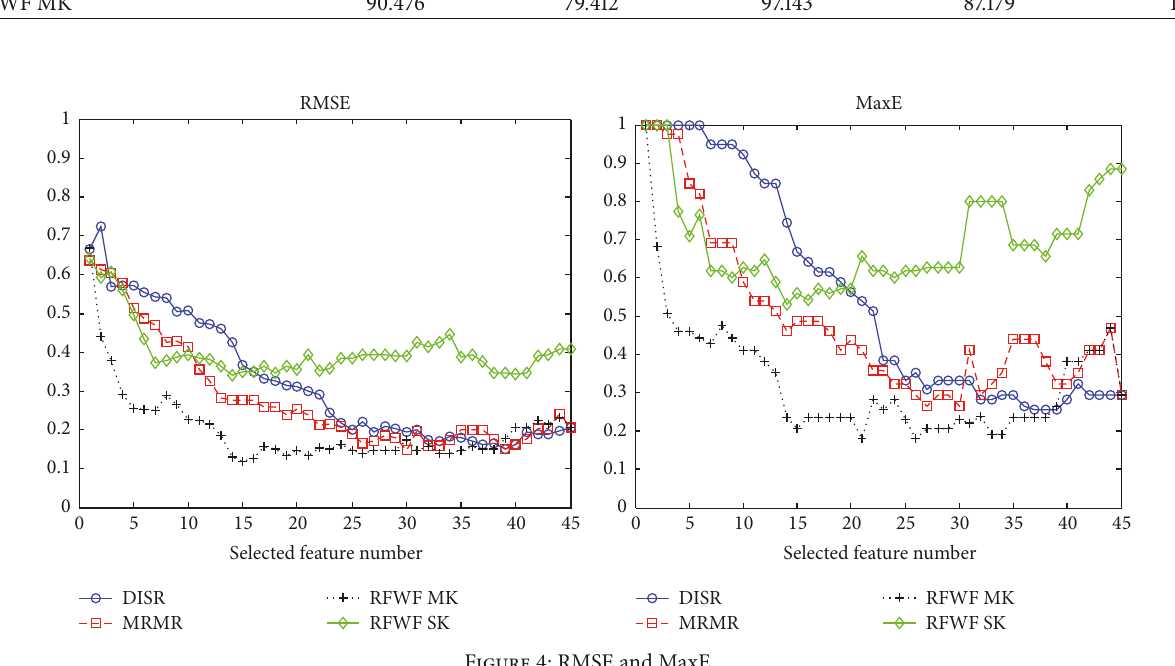
Figure 4: RMSE and